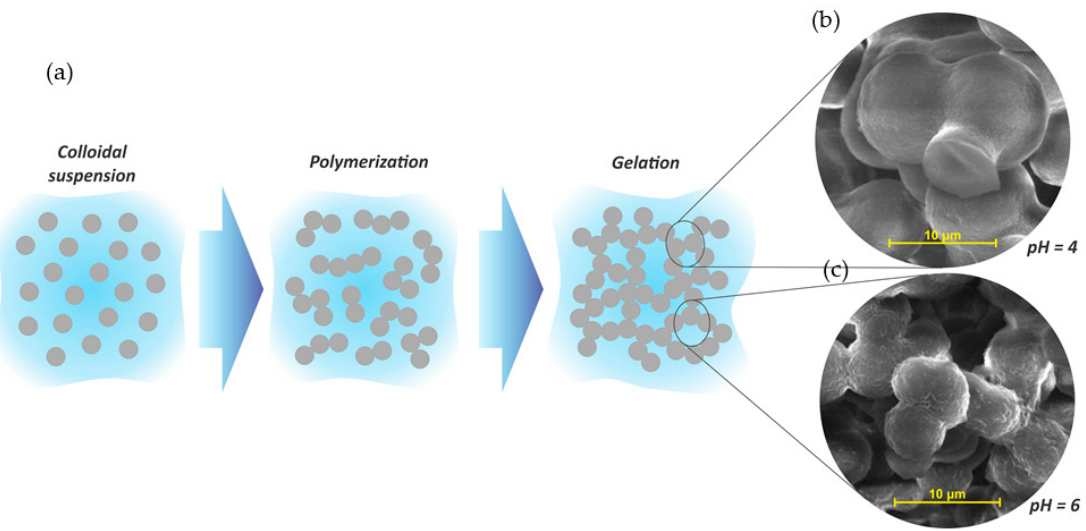
Figure 6. ( a ) Schematic representation of sol-gel process of tannin gels and their respective SEM images at pH 4 ( b ) and pH 6 ( c ). Adapted with permission from reference [61]. Copyright 2013 Elsevier.